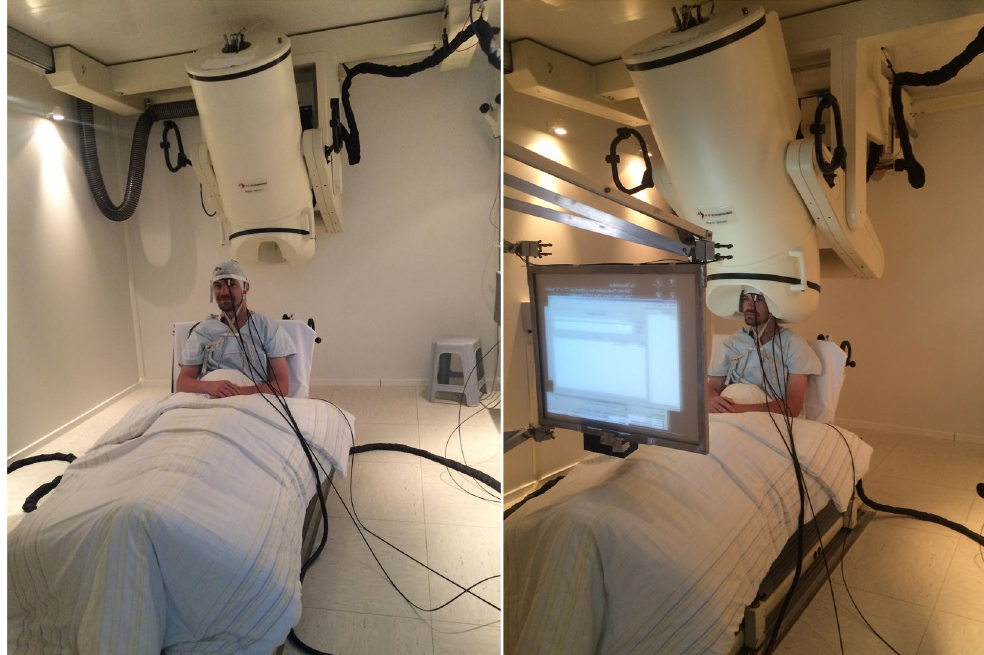
Figure 1. Multimodal setup in MEG environment. In the pictures, the black cables with fibre optics based sensors attached on the body and head are optical fibres for measurements of cNIBP and NIRS. On the right, shown is performing of simultaneous recording with the setup. During imaging, the display is used to instruct the subject to perform the given task.